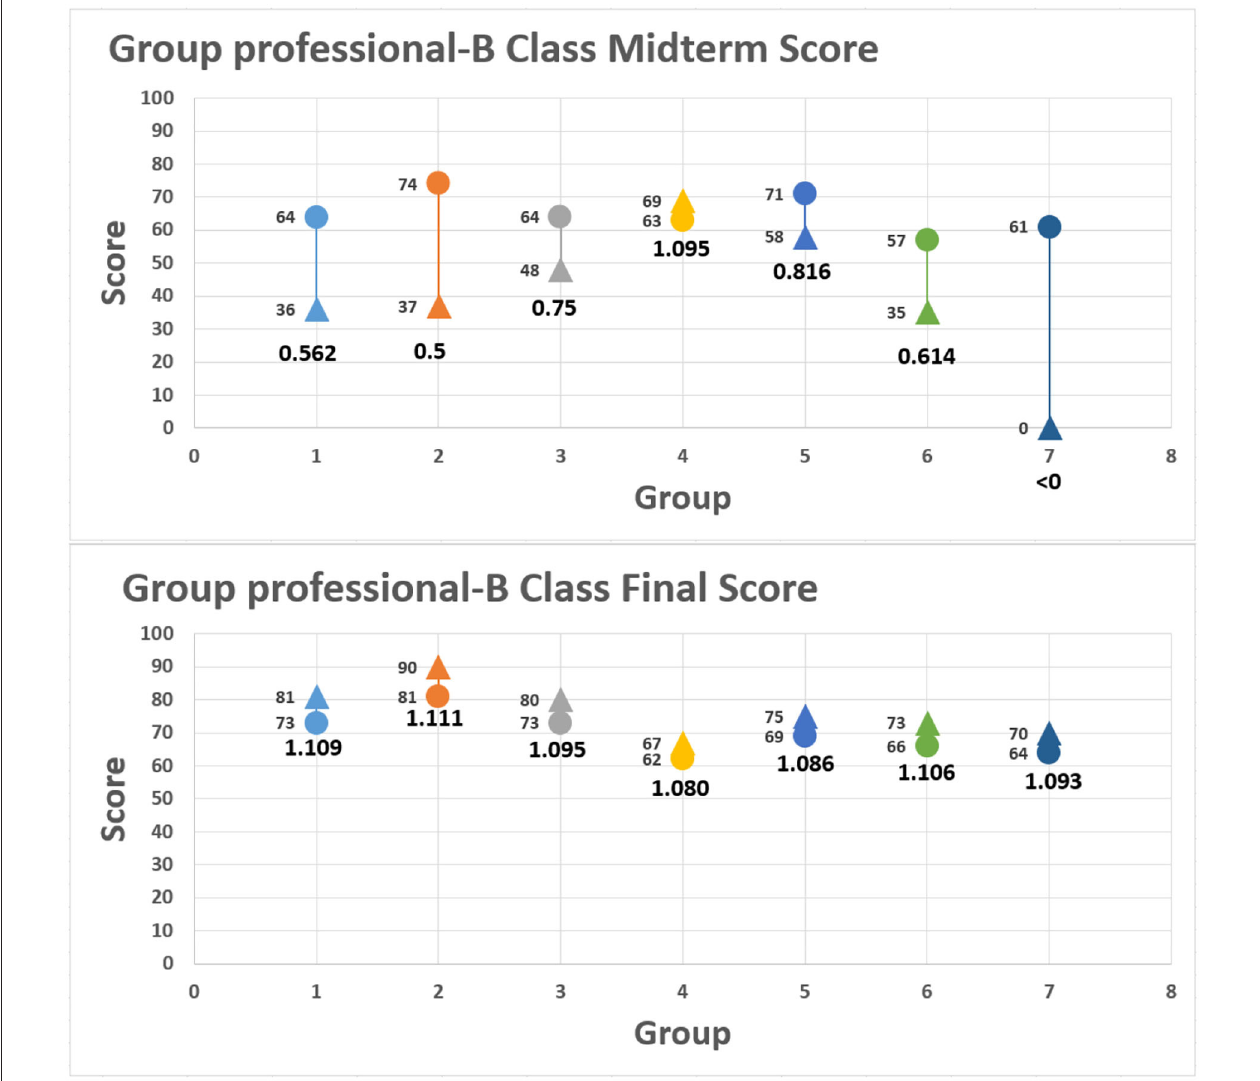
FIGURE 6 | Group professional-level variation : class B.